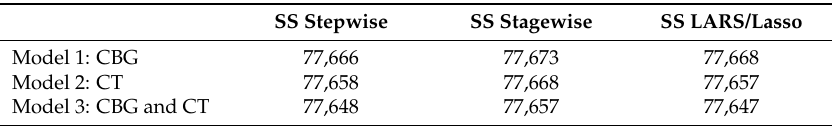
Table 4. OLS-based Akaike’s information criterion comparisons across spatial scale (SS) forward stepwise, forward stagewise, and LARS/lasso models. SS Stepwise SS Stagewise